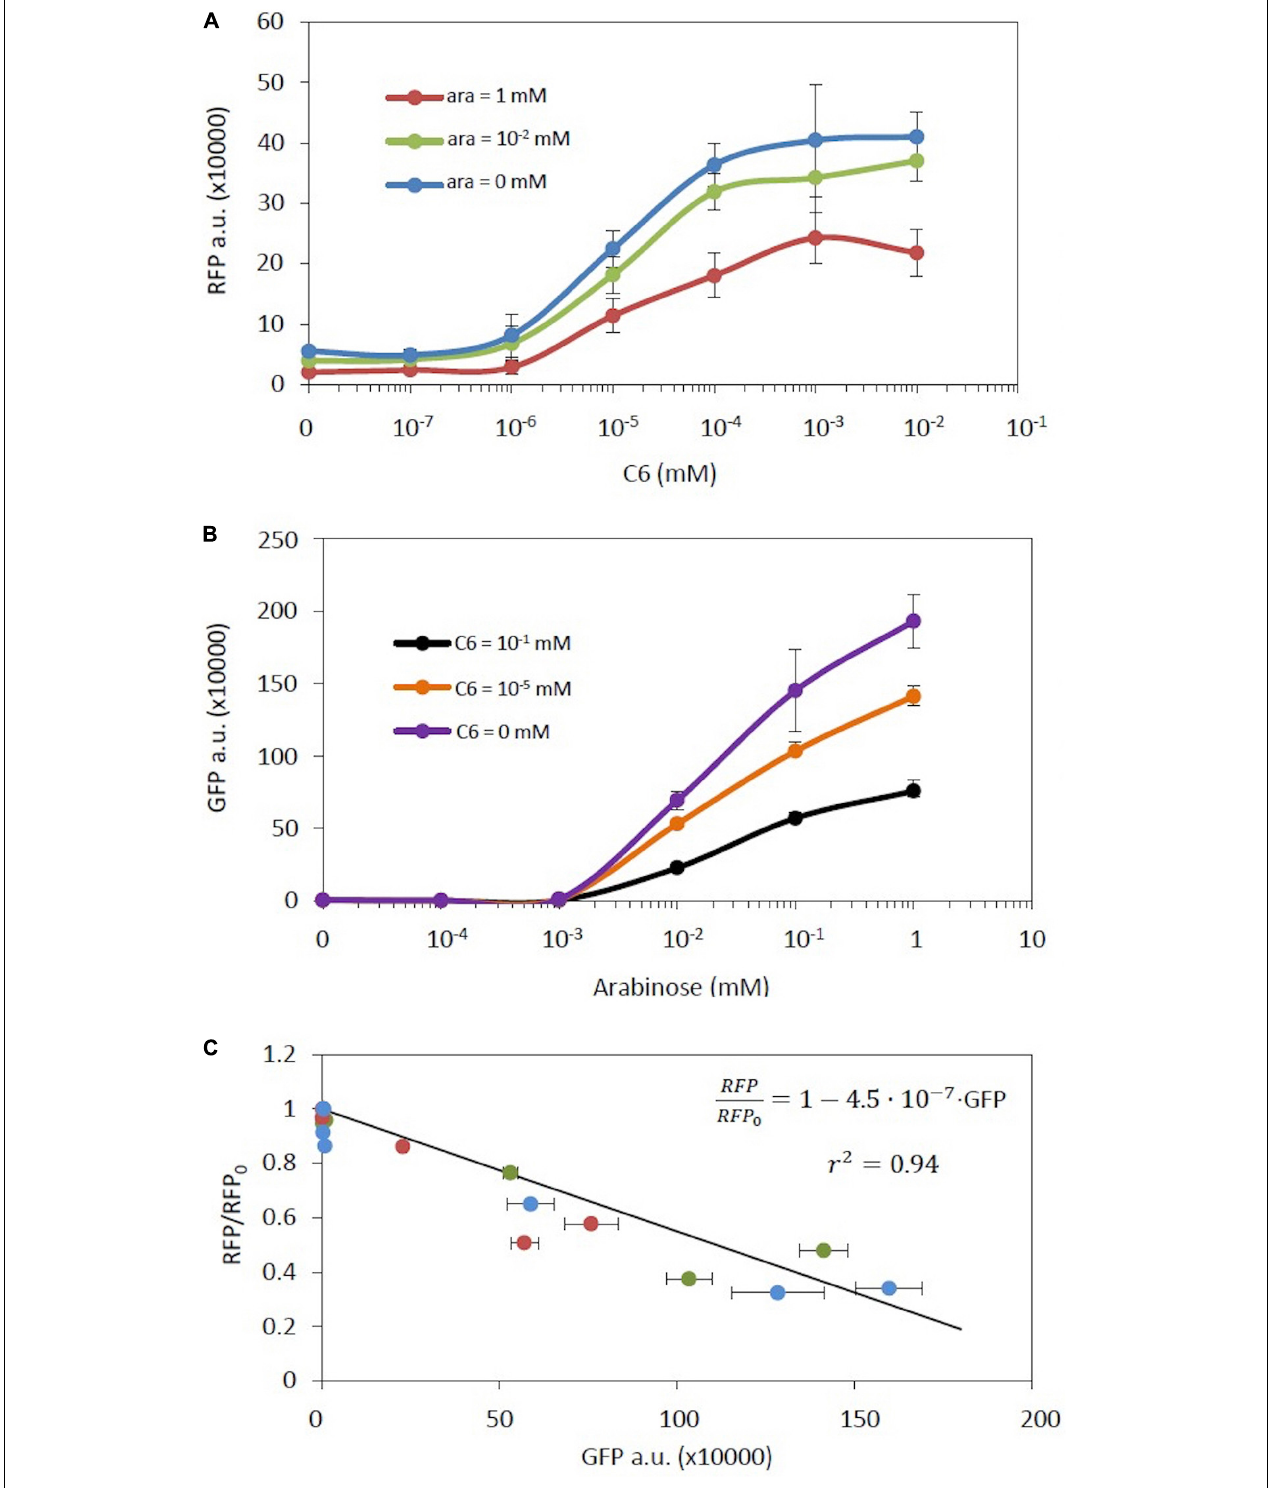
FIGURE 4 | A genetic construct with an inducible RFP and an inducible GFP gene. (A) RFP levels vs. the concentration of its inducer C6 at different arabinose concentrations. (B) GFP levels vs. the concentration of its inducer arabinose at different C6 concentrations. (C) RFP fold-change vs. GFP levels at different C6 concentrations upon different arabinose concentrations. The color code is as in (A) . The solid line represents the model fitting. Error bars are the standard deviations of three independent experiments.